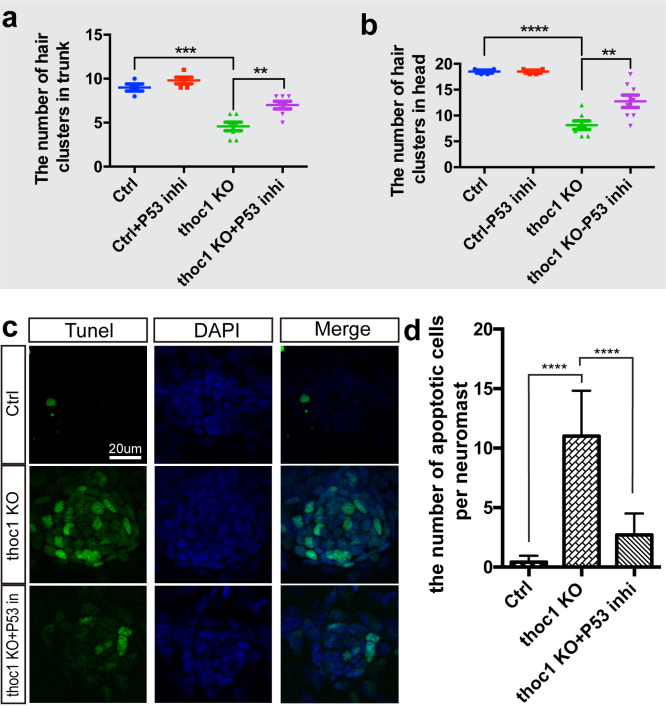
Inhibition of P53 signaling alleviated the thoc1-deficiency induced apoptosis in neuromasts.(a, b) Statistical analysis of the hair cell clusters in control (n = 8), ctrl + P53 inhibitor treatment (n = 9), thoc1 KO (n = 8), and thoc1 KO + P53 inhibitor treatment embryos (n = 7). One-way ANOVA, ****, p<0.0001; ***, p<0.001; **, p<0.01. (c) TUNEL analysis of the neuromasts in control (n = 7), thoc1 KO (n = 7), and thoc1 KO + P53 inhibitor treatment embryos (n = 7). Green: TUNEL staining. Blue: DAPI staining of the cell nuclei. (d) Statistical analysis of the number of apoptotic cells per neuromast in control, thoc1 KO, and thoc1 KO + P53 inhibitor treatment embryos. One-way ANOVA, ****, p<0.0001.